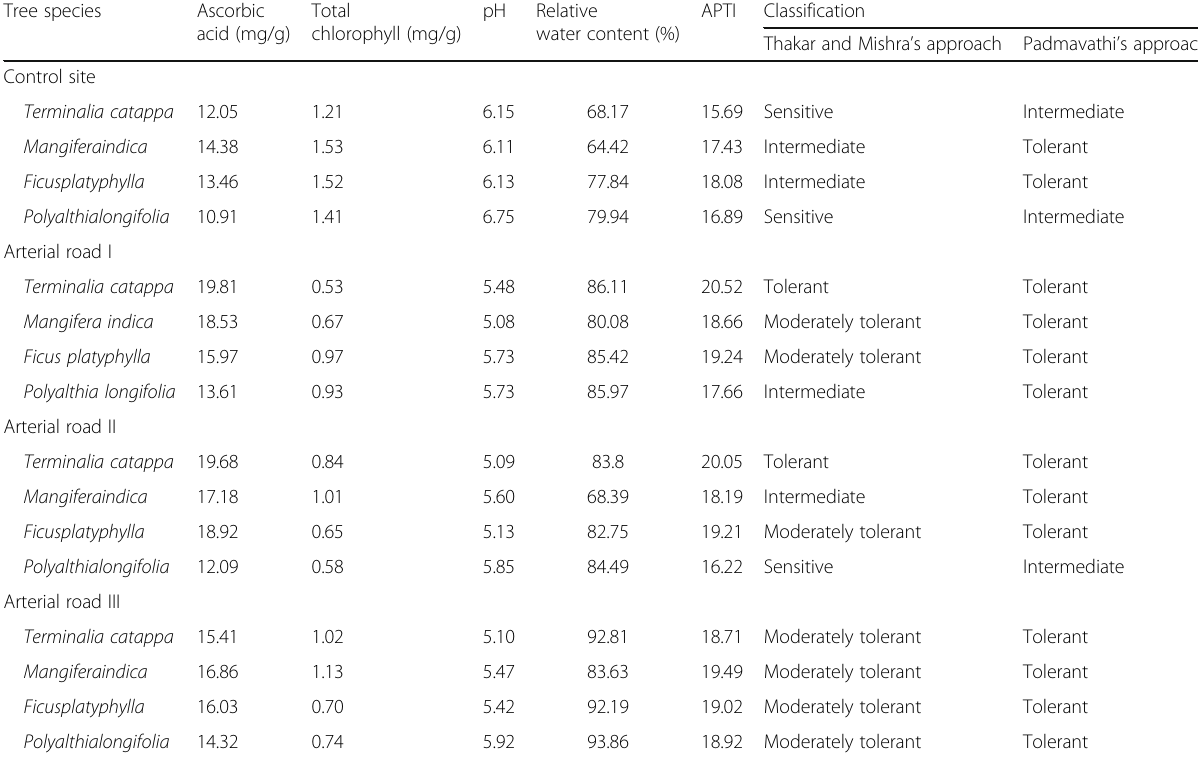
Table 9 Air pollution tolerance index (APTI) and classification for selected tree species in the Kumasi Metropolis Tree species